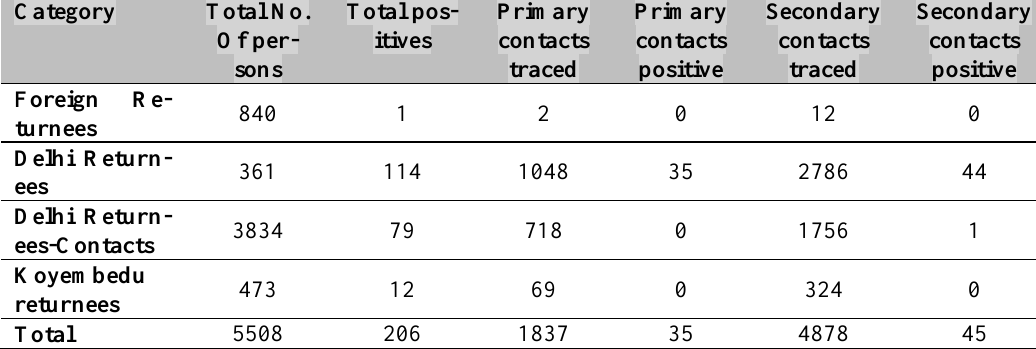
Table 1. Line listing of the cases among returnees in Kurnool by 19 th May 2020